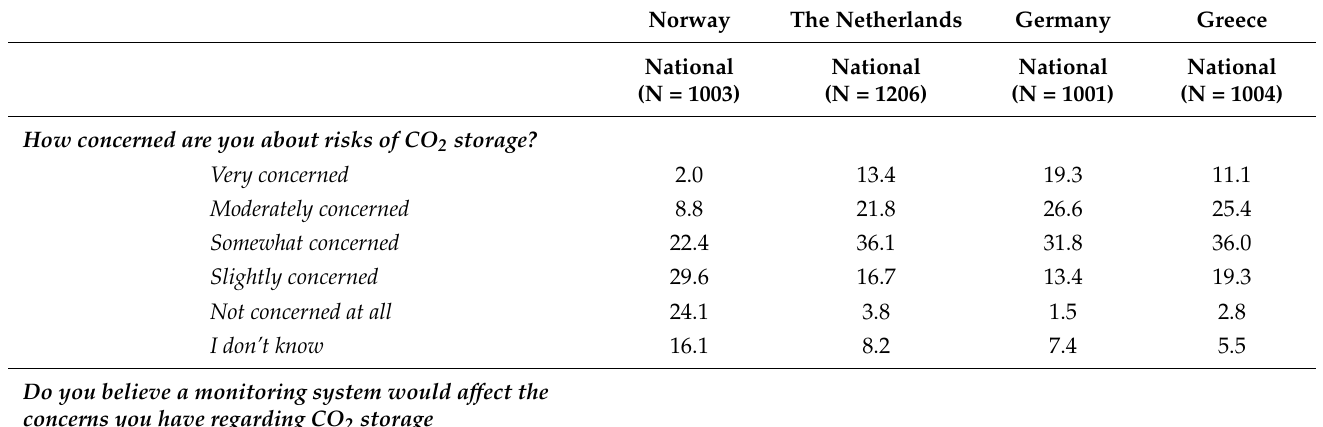
Table 3. Concerns about CO 2 storage and perception of monitoring (percentages, national samples)